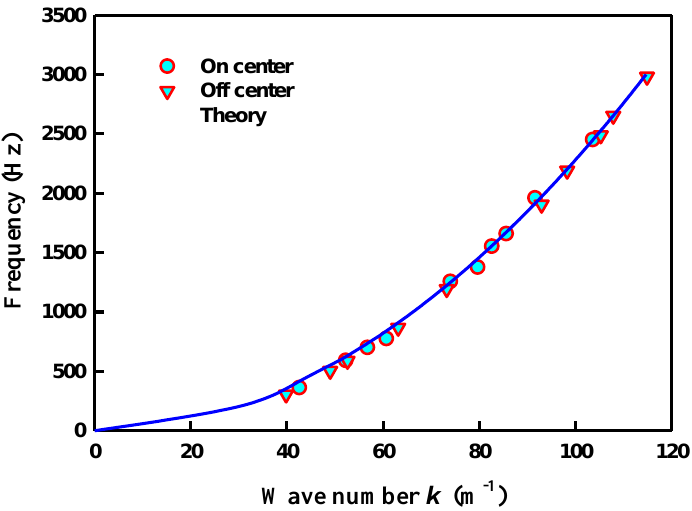
Figure 8. Dispersion relation between the frequency and the wave number determined from the experimental reconstruction shown in Figures 5 and 6.